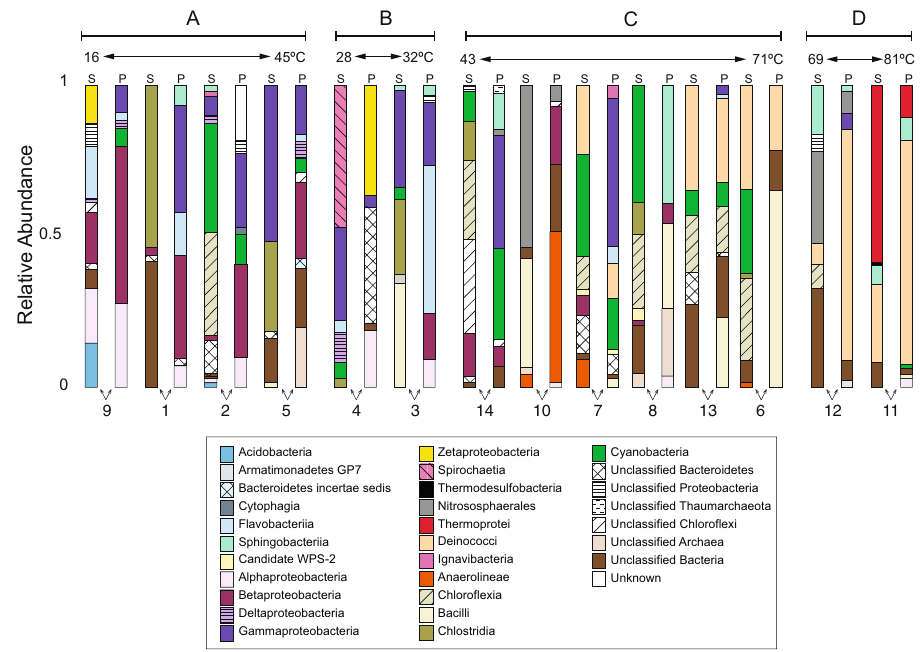
Fig. 3 Hot spring relative abundance of 16S rRNA gene operational taxonomic units (OTUs). The sediment (S) and planktonic (P) community of each hot spring is organized by geochemical group ( A – D ; as determined using PCA), and by increasing hot spring temperature in each group. Only OTUs that were ≥ 1% abundance in any one community were considered. Results are presented at the taxonomic class level.